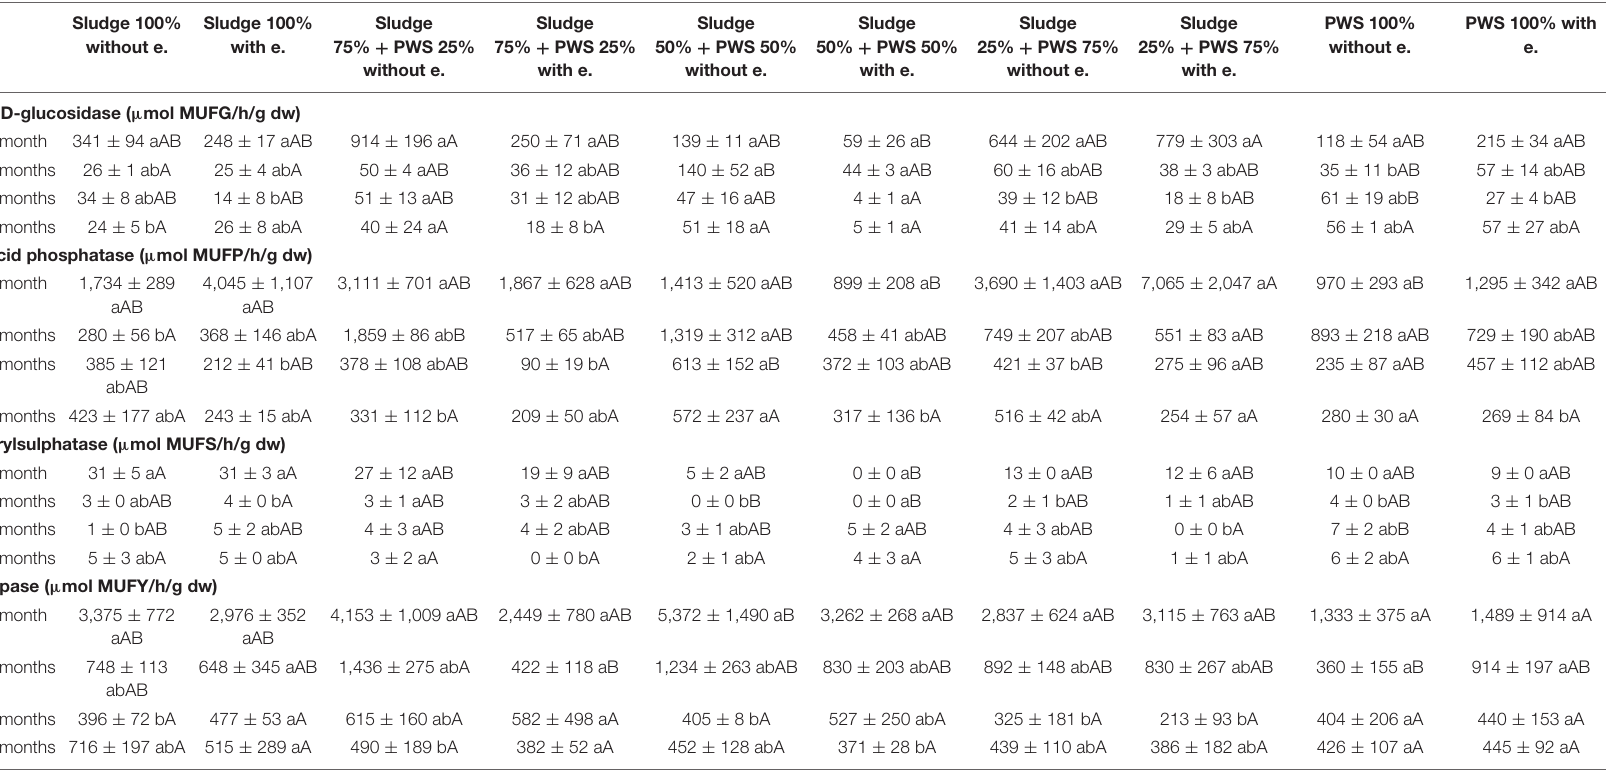
452 ± 128 abA 371 ± 28 bA 439 ± 110 abA 386 ± 182 abA 426 ± 107 aA 445 ± 92 aA Values are means ± SD (n = 3). Different lowercase letters in a column indicate significant differences between months, while capital letters indicate significant differences among treatments (Kruskal–Wallis test, P ≤ 0.05). dw, dry weight; PWS, pelletized wheat straw; e., earthworms; MUFG, 4-methylumbellyferyl- β -D-glucopyranoside; MUFP, 4-methylumbellyferyl-phosphate; MUFS, 4-methylumbellyferyl sulfate potassium salt; MUFY,